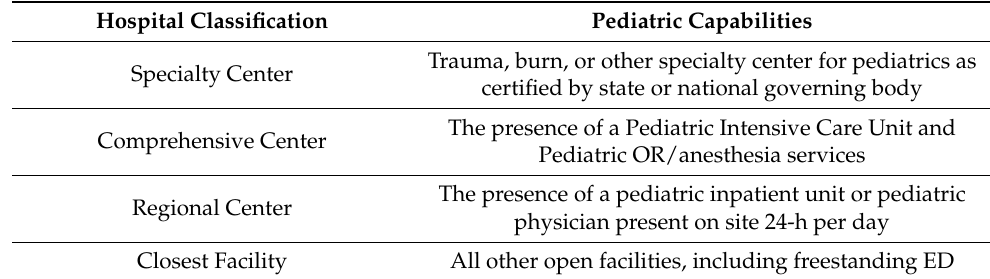
Table 2. Definitions of Pediatric-Facility Capability Levels.